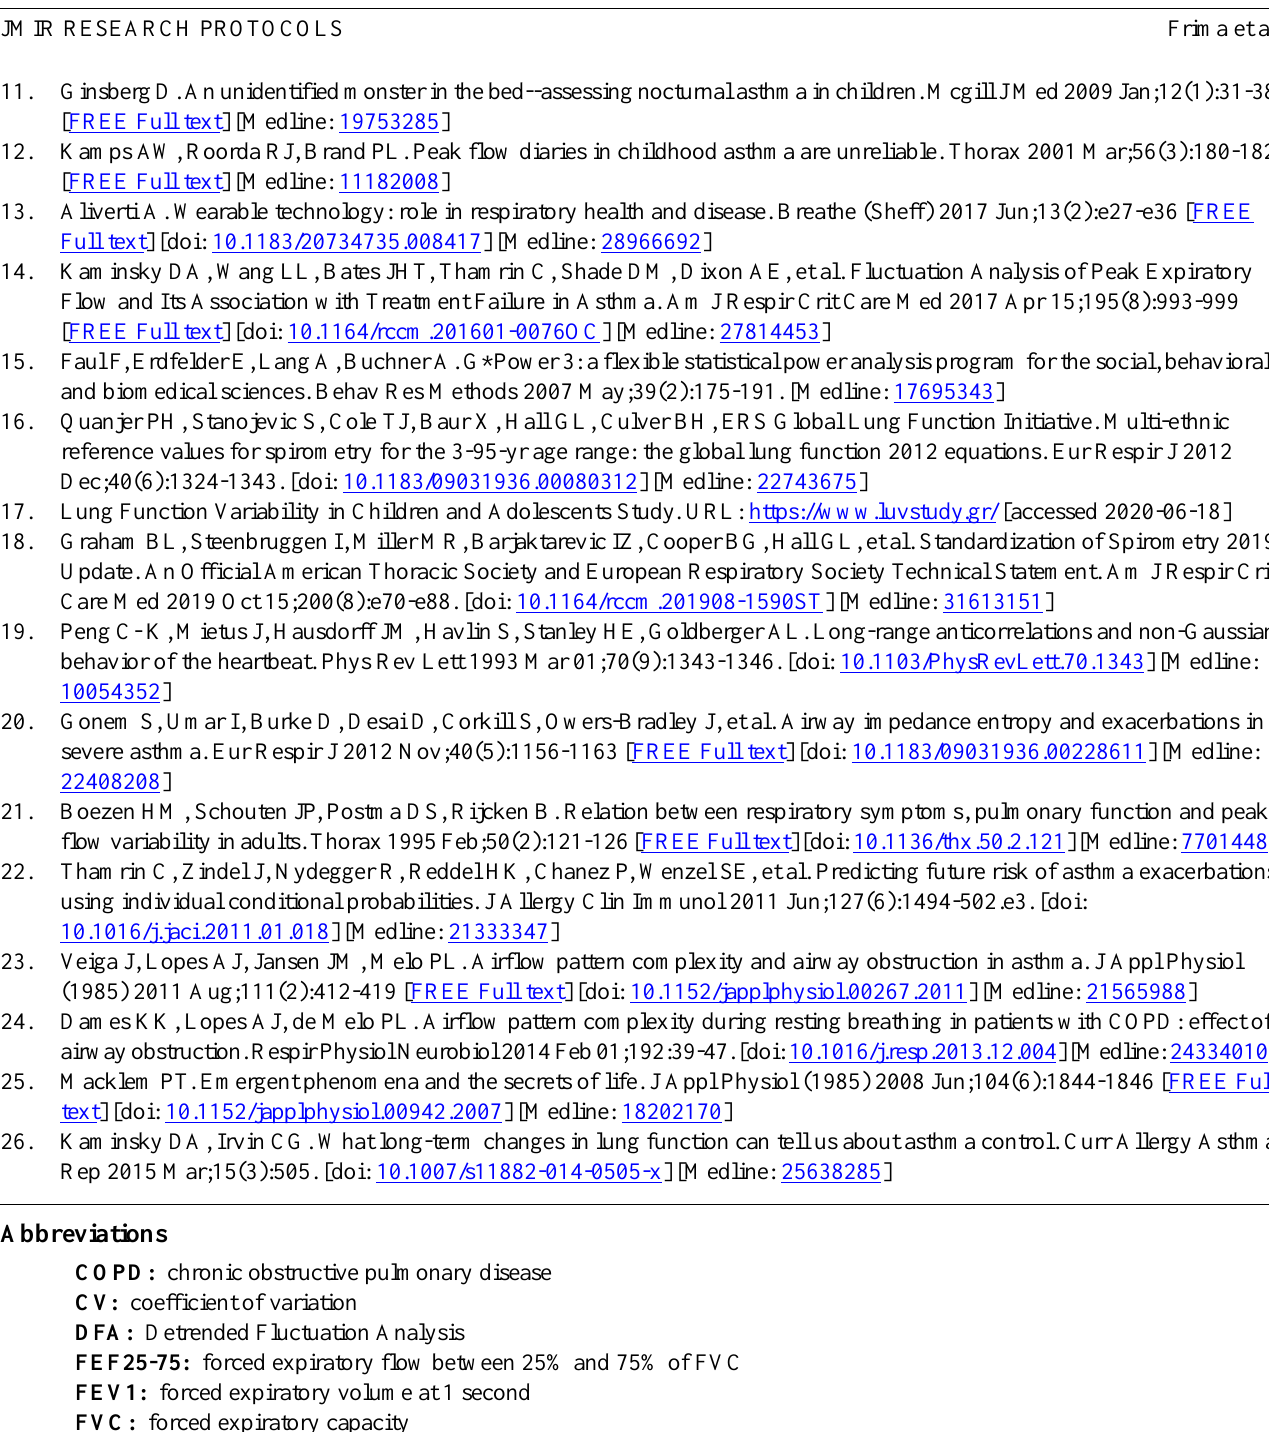
Abbreviations COPD: chronic obstructive pulmonary disease CV: coefficient of variation DFA: Detrended Fluctuation Analysis FEF25-75: forced expiratory flow between 25% and 75% of FVC FEV1: forced expiratory volume at 1 second FVC: forced expiratory capacity GLI: Global Lung Initiative LABA: long-acting beta-2 agonists PEF: peak expiratory flowSampEn: Sample entropy SABA: short-acting beta-2